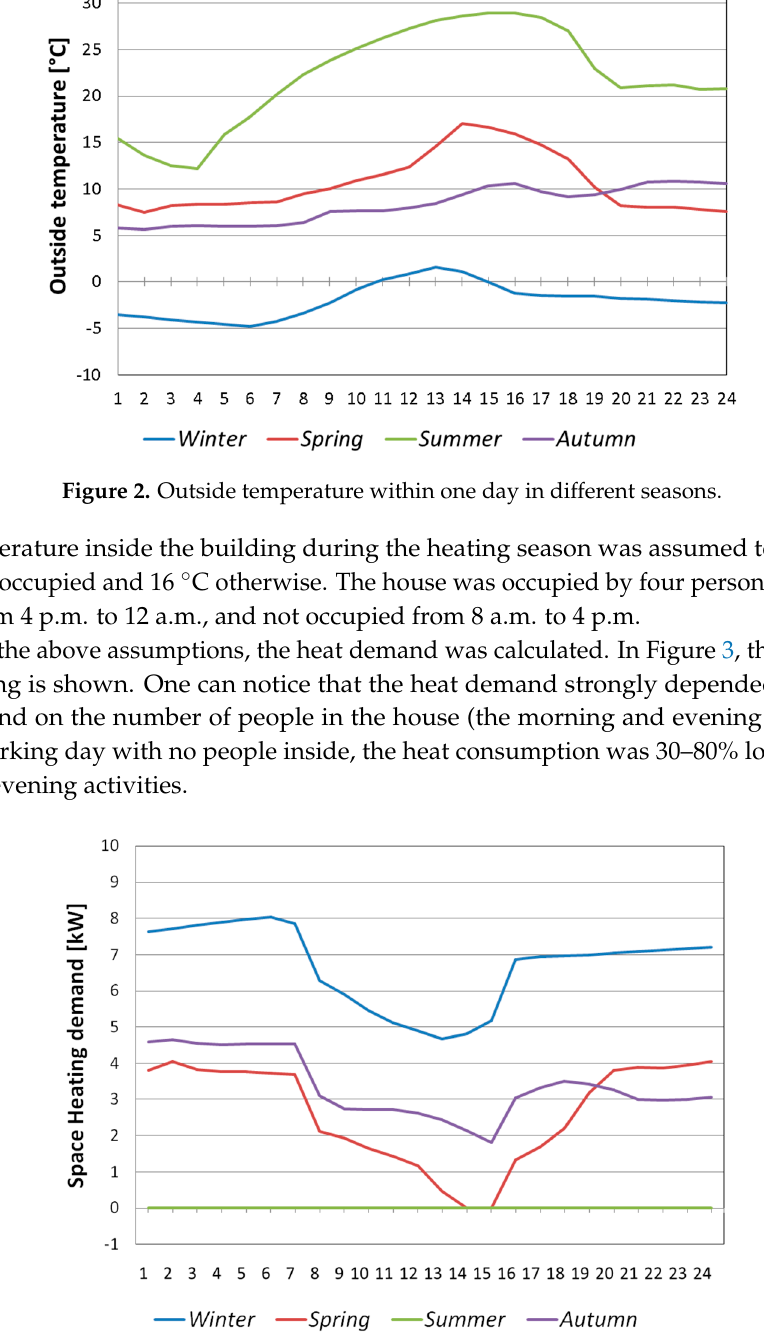
Figure 3. Heat demand for space heating within one day in different seasons.